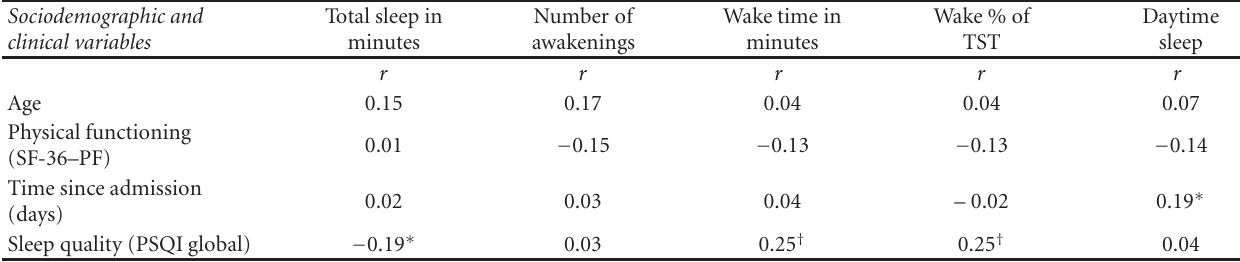
Table 4: Bivariate correlations (Pearson’s r ) between socsiodemographic and clinical variables ( N = 110). Sociodemographic and